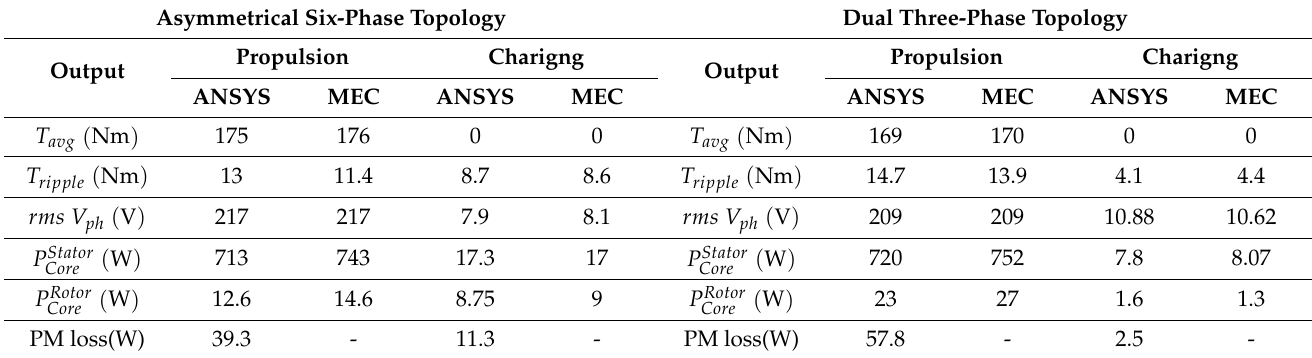
Table 6. Comparison of finite element (FE) and analytical models.